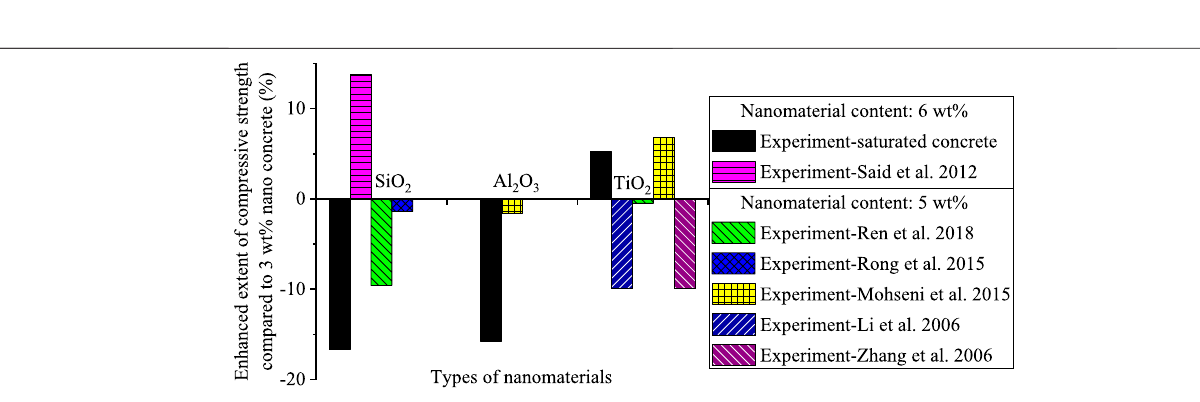
Frontiers in Materials |